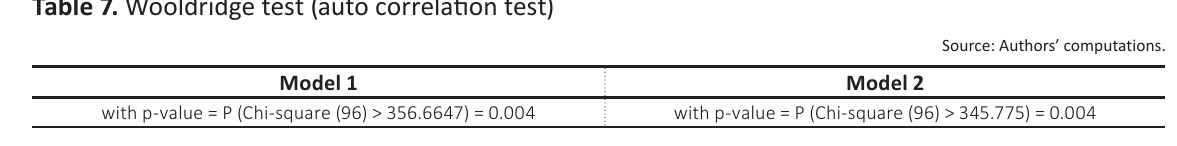
Table 8. Multicollinearity result for the variables (test for multicollinearity)